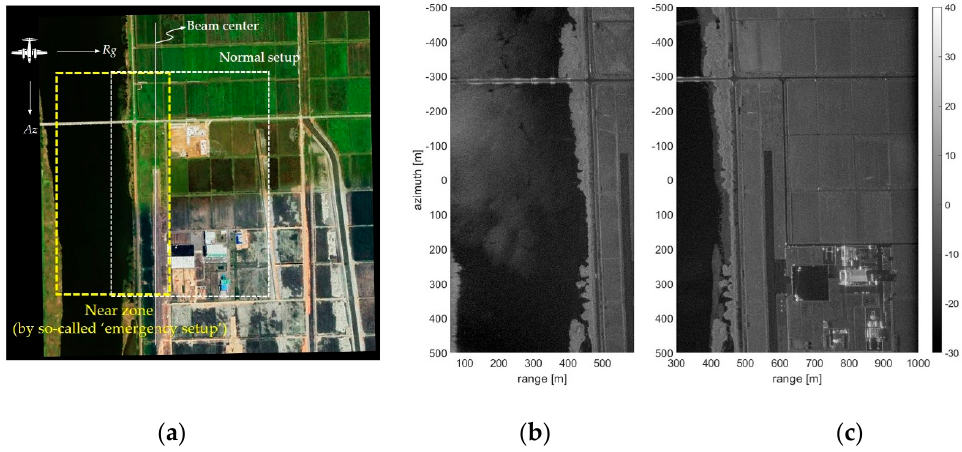
Figure 9. Comparison result of the flight experiment with the di ff erent setups: ( a ) is an optical image of estuary terrain; ( b ) shows the near zone SAR image reconstructed by the shortened delayed-dechirp process of airborne FMCW SAR system, we call it an ‘emergency setup’; and ( c ) shows the SAR image reconstructed by the normal setup as a default,